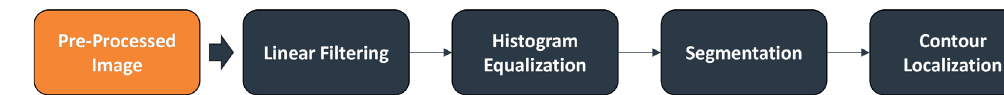
Figure 2. Image post-processing framework.